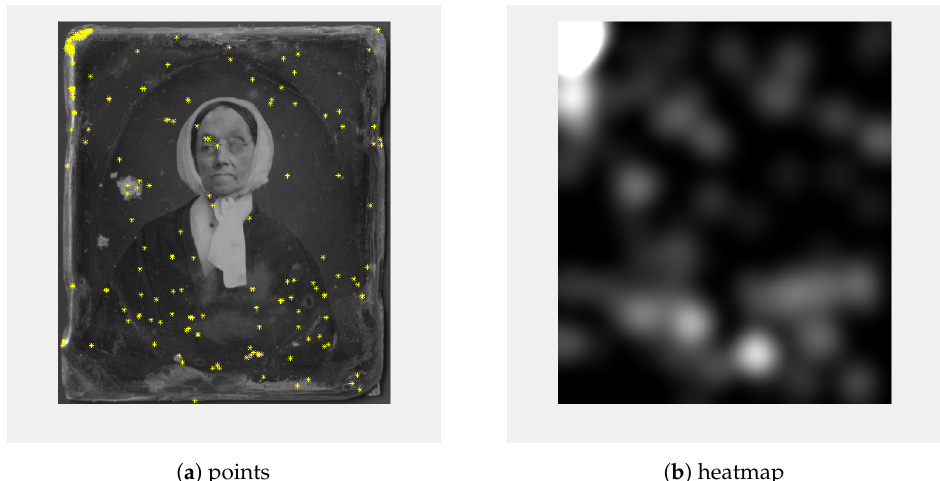
Figure 5. A total 200 points ( a ) and heatmap ( b ) calculated using the Harris corner